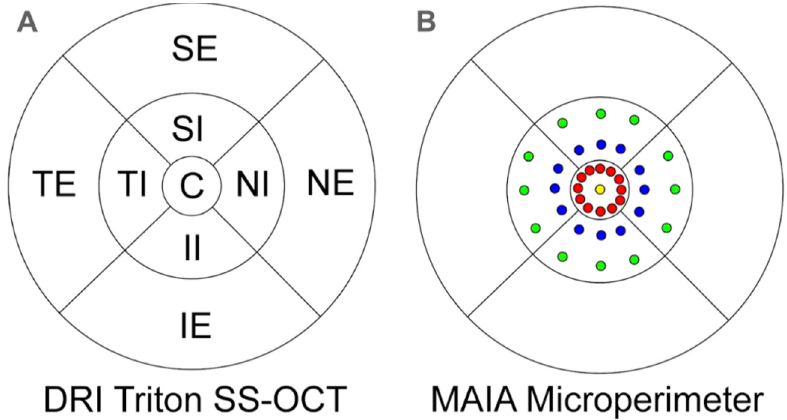
Figure 2. ( A ) ETDRS grid of a right eye divided into nine areas provided by the Deep Range Imaging (DRI) Triton SS-OCT. Four areas for the 6-mm perifoveal ring: nasal external (NE), temporal external (TE), superior external (SE) and inferior external (IE) areas; four areas for the 3 mm parafoveal ring: nasal internal (NI), temporal internal (TI), superior internal (SI) and inferior internal (II) areas; and the 1-mm central area. ( B ) The 37 sensitivity points provided by the Macular Integrity Assessment (MAIA) microperimeter and its location: one in the center (yellow), 12 in the 1 ◦ radius (red), 12 in the 3 ◦ radius (blue) and 12 in the 5 ◦ radius (green). One degree is equivalent to a radius of 0.3 mm; 3 ◦ to a radius of 0.9 mm; and 5 ◦ to a circle with a 1.5-mm radius. The center point and the 1 ◦ sensitivity points (0.6-mm diameters) correspond to the ETDRS 1-mm diameter center ring, and the localized sensitivity points at 3 and 5 ◦ (diameters of 1.8 and 3 mm, respectively) to the 3-mm diameter parafoveal ring of the ETDRS